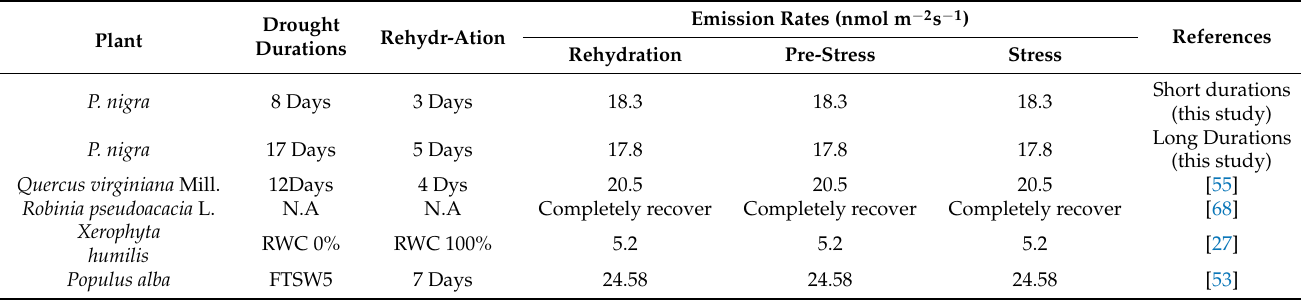
Table 2. The isoprene emission rates in rehydration durations of this study and other studies.